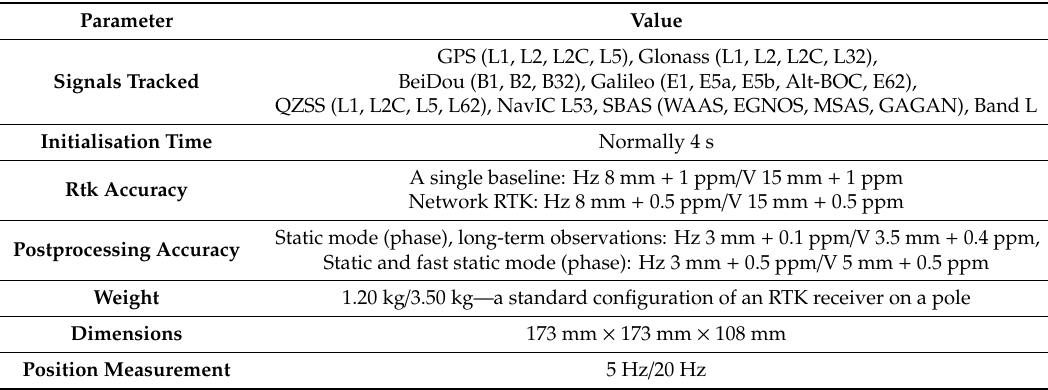
Table 1. Selected parameters of a LEICA GS 18T receiver.